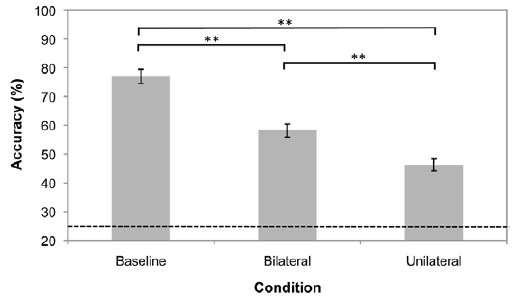
Figure 4. Mean tracking accuracy for the three conditions in Experiment 3. Broken line shows chance performance is 25%. Error bars are within-observers standard error. **Significantly different at p ,